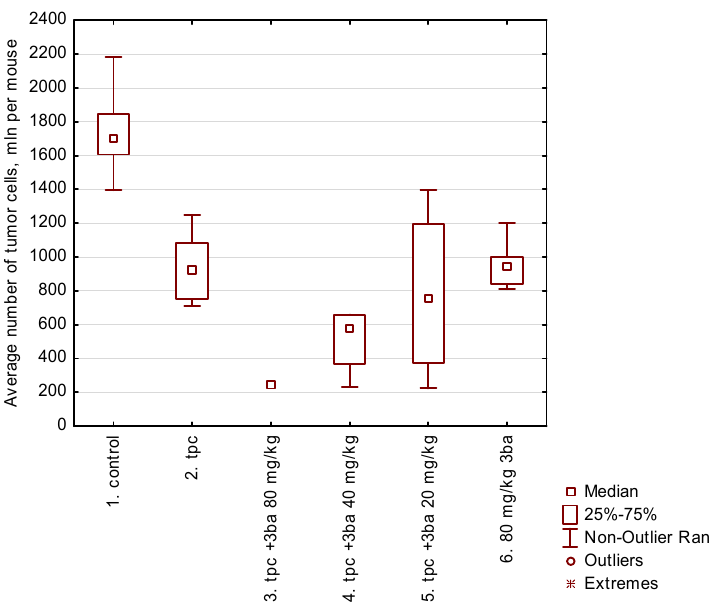
Figure 5. A box plot of the 3ba influence on the number of tumor cells in ascites.